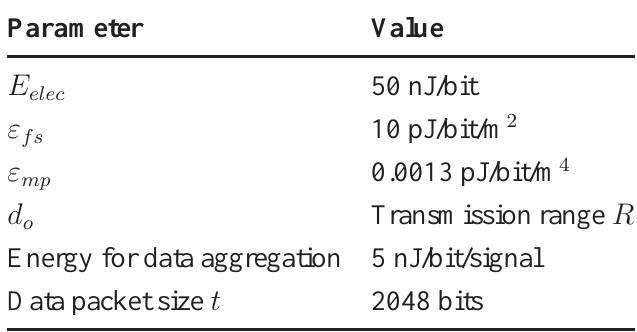
Table 3. The Values of Simulation Parameters